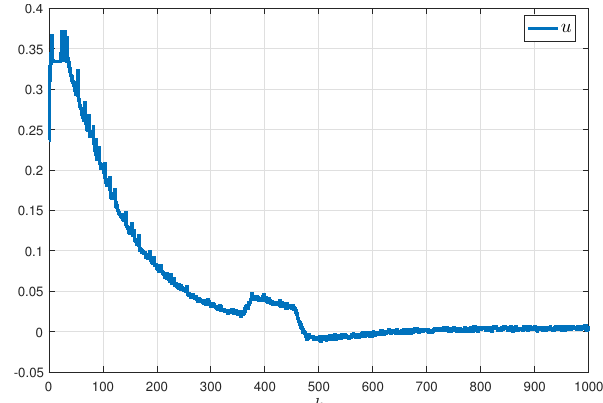
Figure 10. Control response u ( k ) .